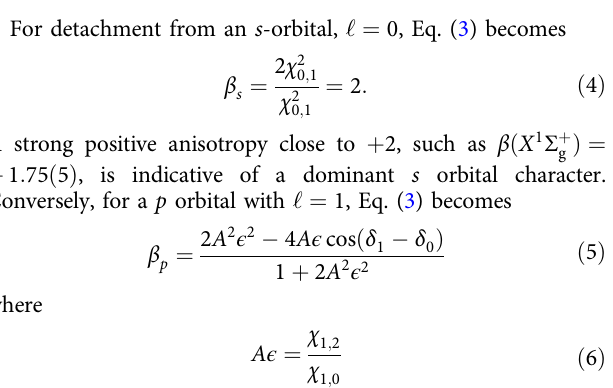
photodetachment. Experimental Fig. 6 Anisotropy parameters for C (cid:1) 2 values are show for detachment at 295 – 355 nm [from this work (circles/ squares)] and at 264 nm [from ref. 26 (stars/crosses)]. Detachment to the orbital character of f ¼ 92 % s (orange curve), whereas detachment to the excited a 3 Π state has a Hanstorp coef fi cient of A ¼ 0 : 86 ð 6 Þ eV (cid:1) 1 and an u orbital character of f ¼ 13 % s (blue curve). Anisotropy curves calculated from Dyson orbitals are also shown (red and blue dashed lines). Error bars represent 1 SD, de fi ned by the covariance matrix of the least-squares fi t to Eq.